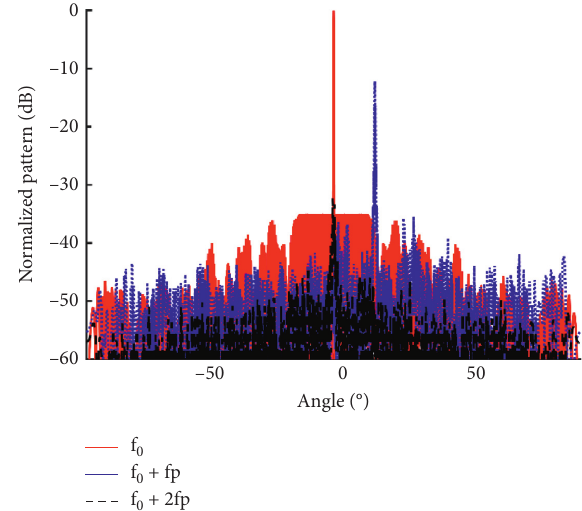
Figure 5: Optimized pattern at the central frequency and at the first two sidebands of TMA.